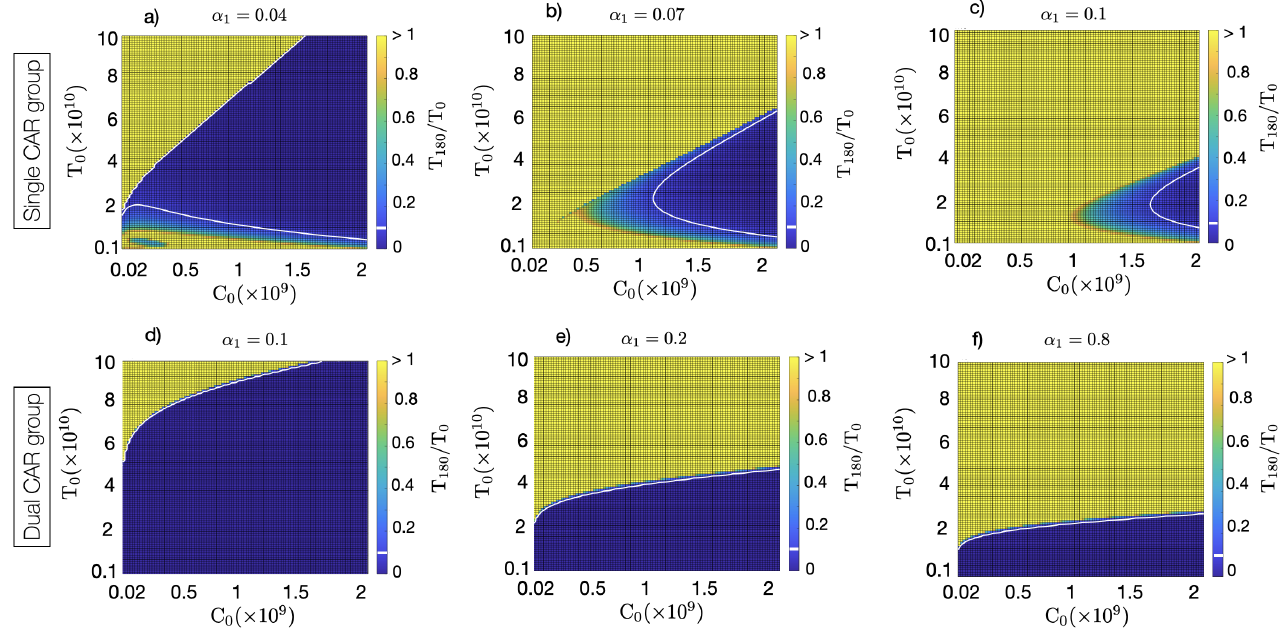
Figure 6. Colormap plots of the percentage of change in tumour load at six months compared to the initial load measured by the fraction T ( 180 ) / T 0 , as a function of the initial number of CAR-T and tumour cells, over three immune suppression scenarios: ( a ) α 1 = 0.04 day − 1 , ( b ) α 1 = 0.07 day − 1 , ( c , d ) α 1 = 0.1 day − 1 , ( e ) α 1 = 0.2 day − 1 and ( f ) α 1 = 0.8 day − 1 . Dark blue areas, delimited by the white lines, show the initial configurations of injected CAR-T cells ( C 0 ) and tumour loads ( T 0 ) leading to tumour control after six months. Subplots ( a – c ) show the results obtained using a single CAR as governed by Equations (1) and (2). Subplots ( d – f ) shows results of computer simulations with the dual CARs obtained using Equations (3)–(6). Parameter values used in the simulations were τ C = 7 days, ρ ¯ C = ρ C = 0.9 day − 1 , ρ T = 1/50 day − 1 , α 2 = 2.5 × 10 − 10 day − 1 cell − 1 , g T = 10 10 , g C = 2 × 10 9 , g B = 10 10 , k = 0.2, α B = 4.5 × 10 − 11 day − 1 cell − 1 and τ B = 60 day − 1